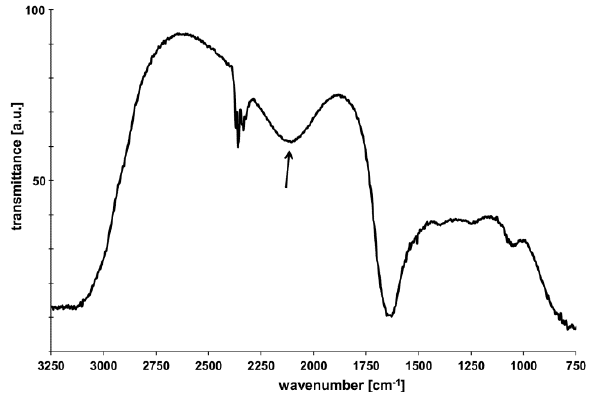
Figure 2. Fourier transform infrared (FT-IR) spectrum of HNTs: the arrow indicates the peak due to the Si–H signal (2120 cm − 1 ).